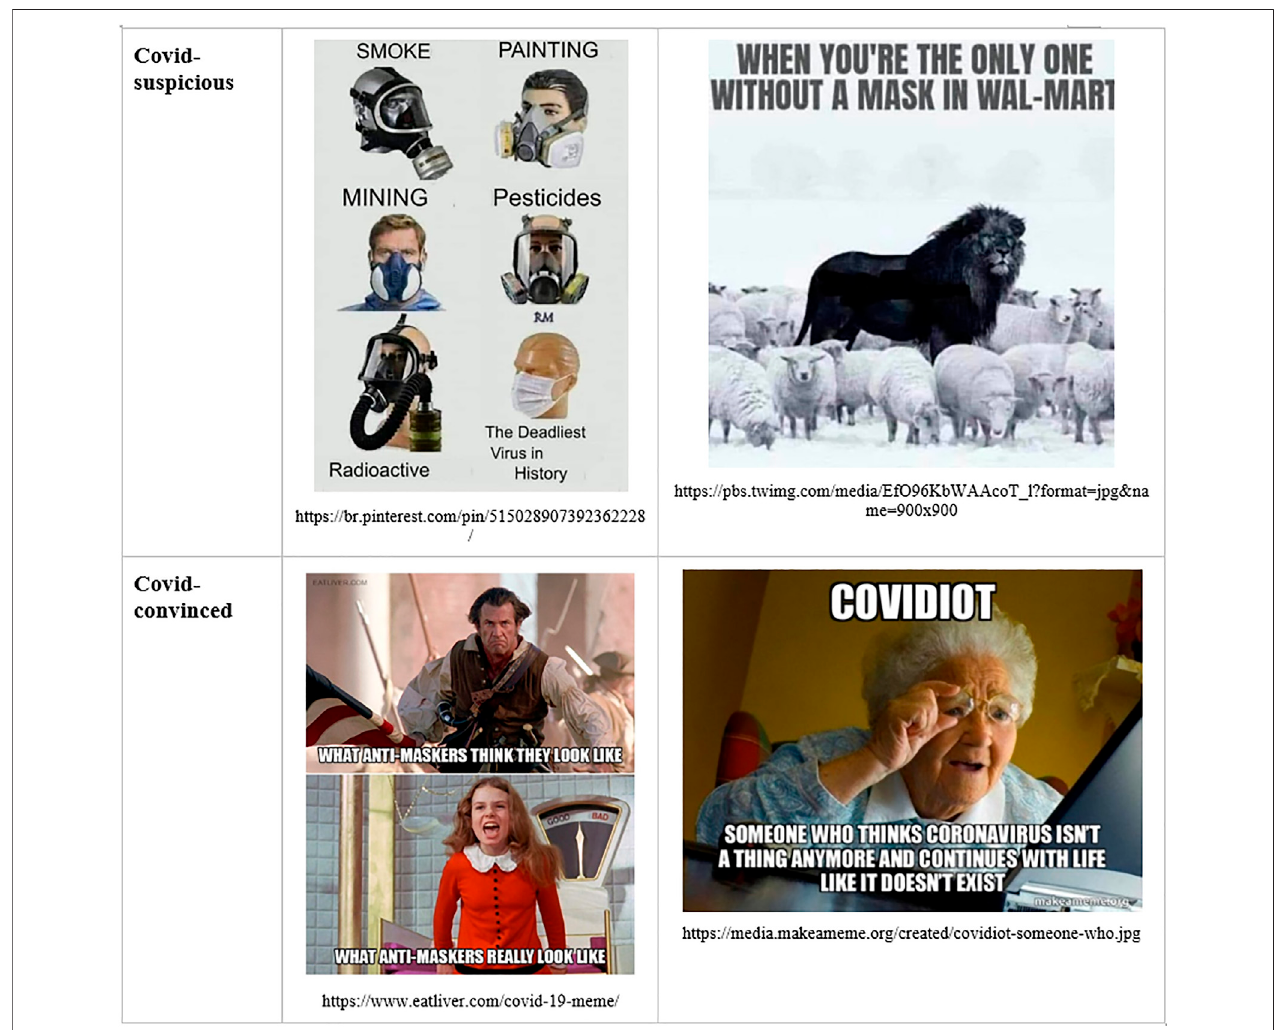
FIGURE 9 | Boundary maintenance in Covid-skeptical and Covid-anxious